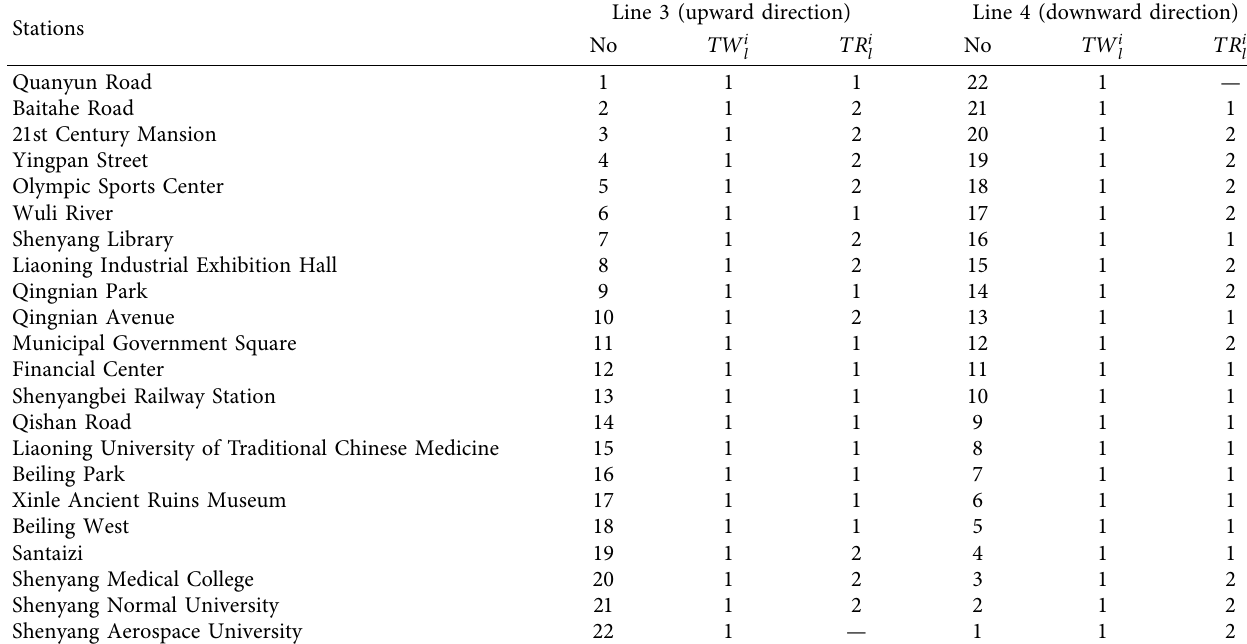
Table 13: Dwell time and running time of the trains on line 2 in Shenyang Metro.